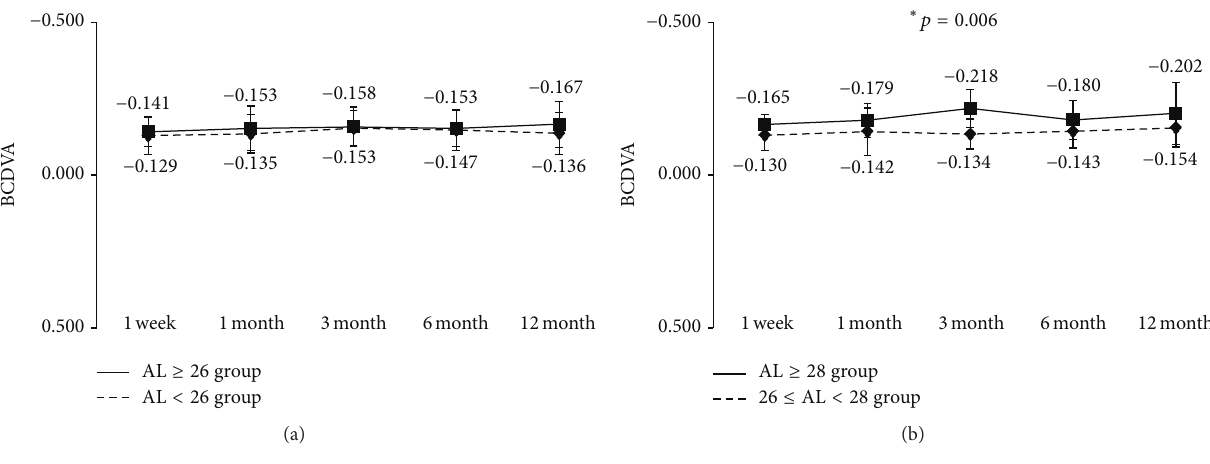
Figure 2: Best corrected distance visual acuity during 12-month follow-up after implantation of multifocal intraocular lens. (a) Eyes were divided into axial length of 26mm or longer (AL ≥ 26 group) and less than 26mm (AL < 26 group). (b) Eyes in AL ≥ 26 group were further divided into 26 ≤ AL < 28 group and AL ≥ 28 group. ∗ Mann-Whitney 𝑈 test.